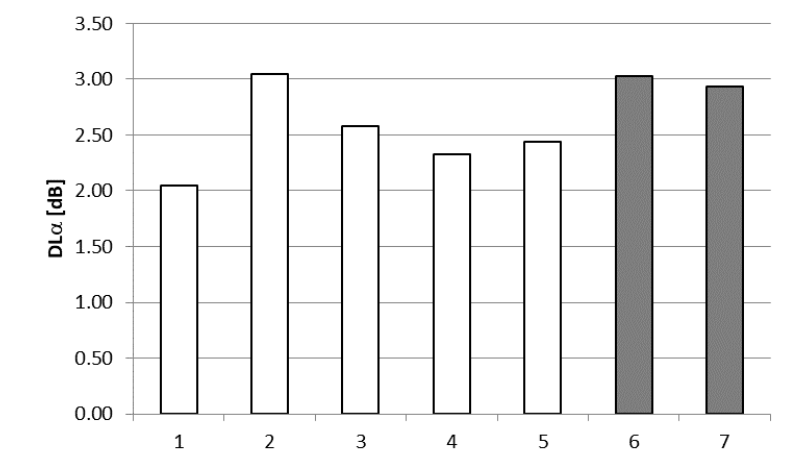
Figure 6. Overview of the calculated single-number values of sound absorption ČSN EN